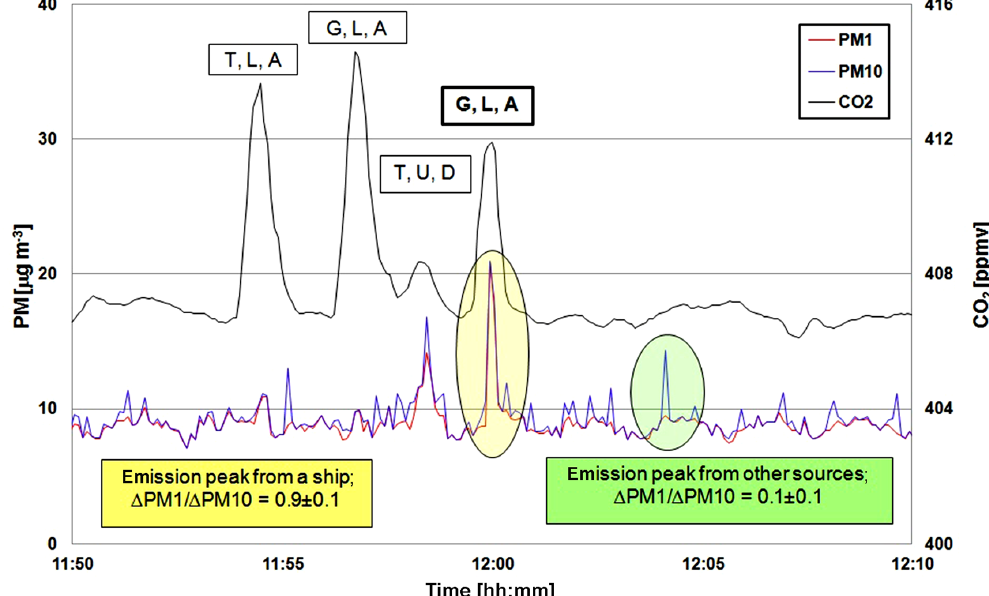
Figure 4. Temporal variation of CO 2 , PM 10 and PM 1 at the measurement site on 20 February 2013 from 11:50 to 12:10LT for differ- ent ship types (G = goods ship, T = petroleum tanker) and different operation parameters (L = loaded, U = unloaded, A = upstream and D = downstream).